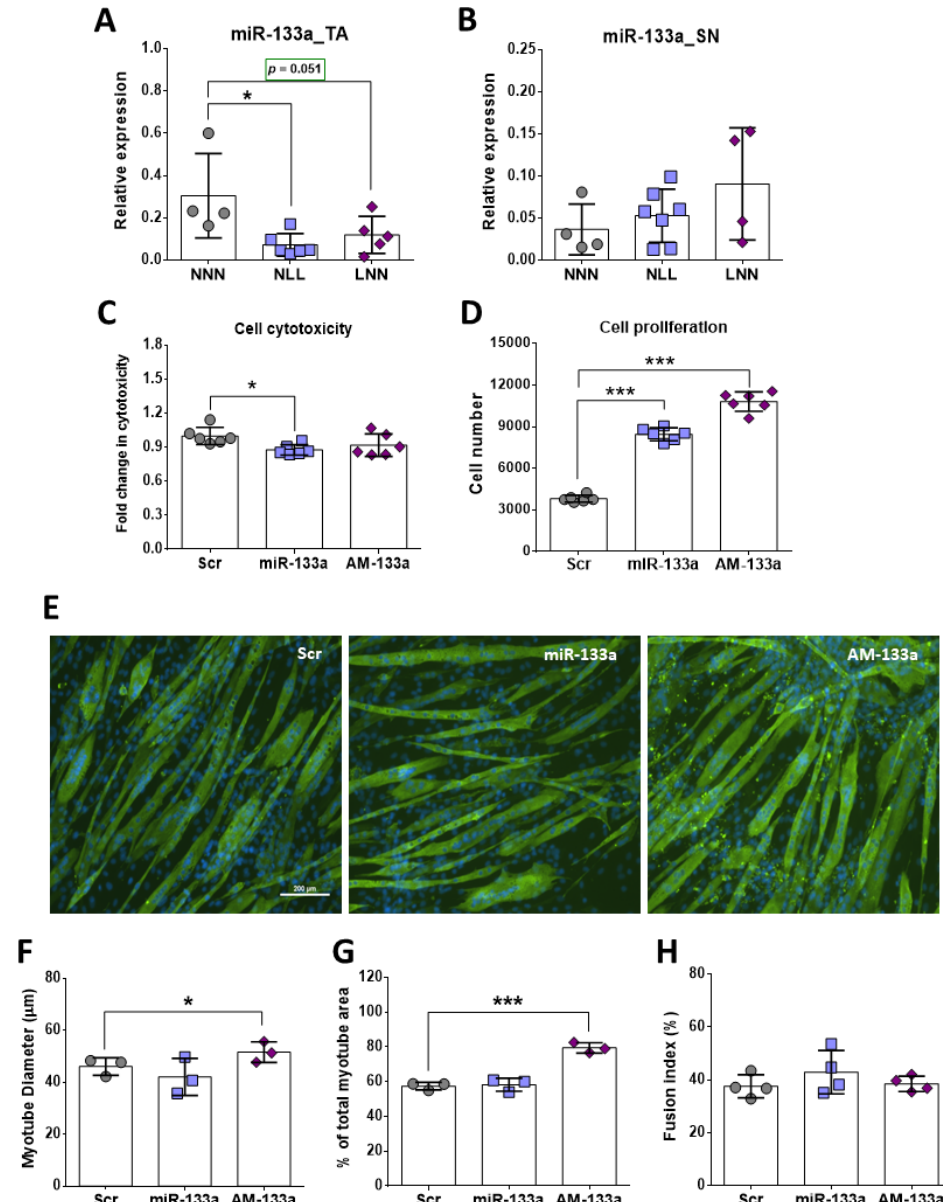
Figure 6. Expression analysis of miR-133 in TA muscle ( A ) and sciatic nerve ( B ). CytoTox96 cytotoxicity assay (following treatment of cells with H 2 O 2 and miR-133/AM133) ( C ) and CCK-8 proliferation assay ( D ) of C2C12 myoblasts following transfection with Scr, miR-133 or AM-133. Representative images of C2C12 myotubes transfected with miR-133 or AM-133 stained for myosin heavy chain (MyHC) and nuclei ( E ) (MF20 = Green; DAPI = Blue). Myotube diameter ( F ) area per field of view ( G ) and fusion index ( H ) were used as measures of myotubes. Scale bars = 200 μ m. * p ≤ 0.05 and *** p ≤ 0.001 (mean ± SD; n = 3–7).